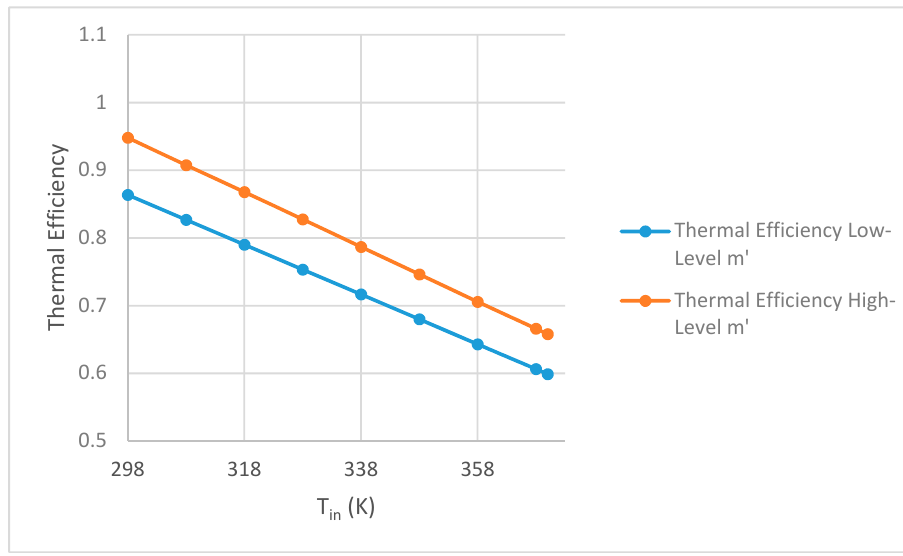
Figure 14. Effect of flowrate thermal efficiency at two levels flowrate.